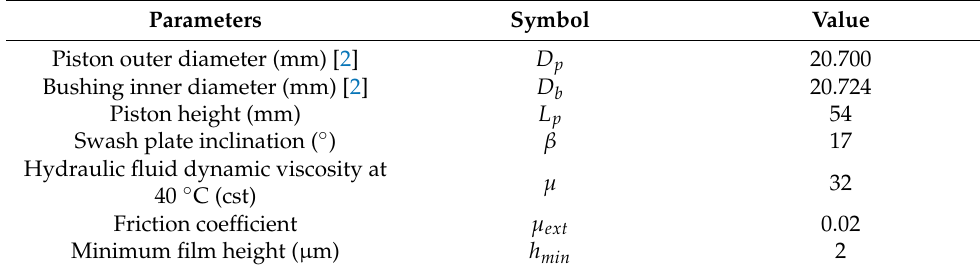
Table 1. Simulation